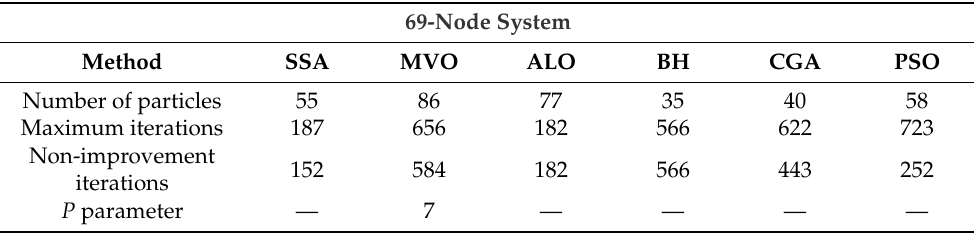
Table 3. Parameters of the continuous methods employed here in the master stage for the 69- node